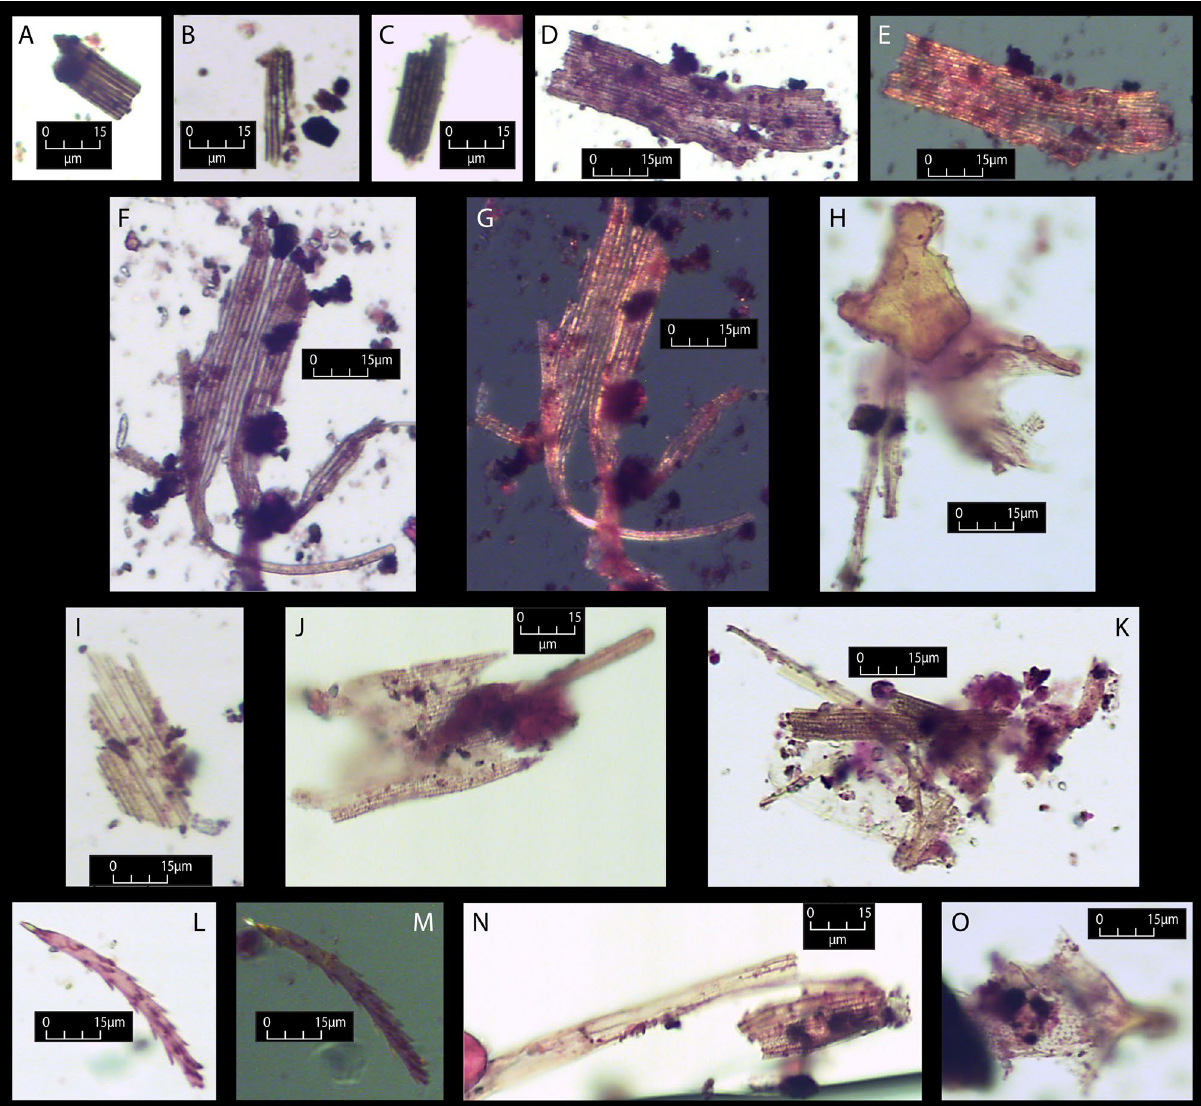
Figure 5. Examples of Bogong moth segments from lifted samples (all at × 400 magnification). ( A ) Partially carbonised wing structures from Sample 2 (pp). ( B ) Partially carbonised wing structure and carbonised material from Sample 2 (pp). ( C ) Partially carbonised moth wing segment from Sample 4 (pp). ( D–E ) Damaged moth wing segment from Sample 6 ( D pp; E xp). ( F–G ) Damaged moth wing segment from Sample 6 ( F pp; G xp). ( H ) Damaged moth wing segment with proteinaceous material, from Sample 6 (pp). ( I ) Unburnt moth wing segment from Sample 4 (pp). ( J ) Damaged moth wing segment with attachment, from Sample 6 (pp). ( K ) Damaged moth wing segments from Sample 6 (pp). ( L–M ) Probable moth hind leg from Sample 6 ( L pp; M xp). ( N ) Damaged moth wing segment from Sample 6 (pp). ( O ) Damaged moth wing segment with attachment, from Sample 6 (pp). Light source = plane (pp), part polarised (part pol) and cross-polarised (xp) (photos: Birgitta